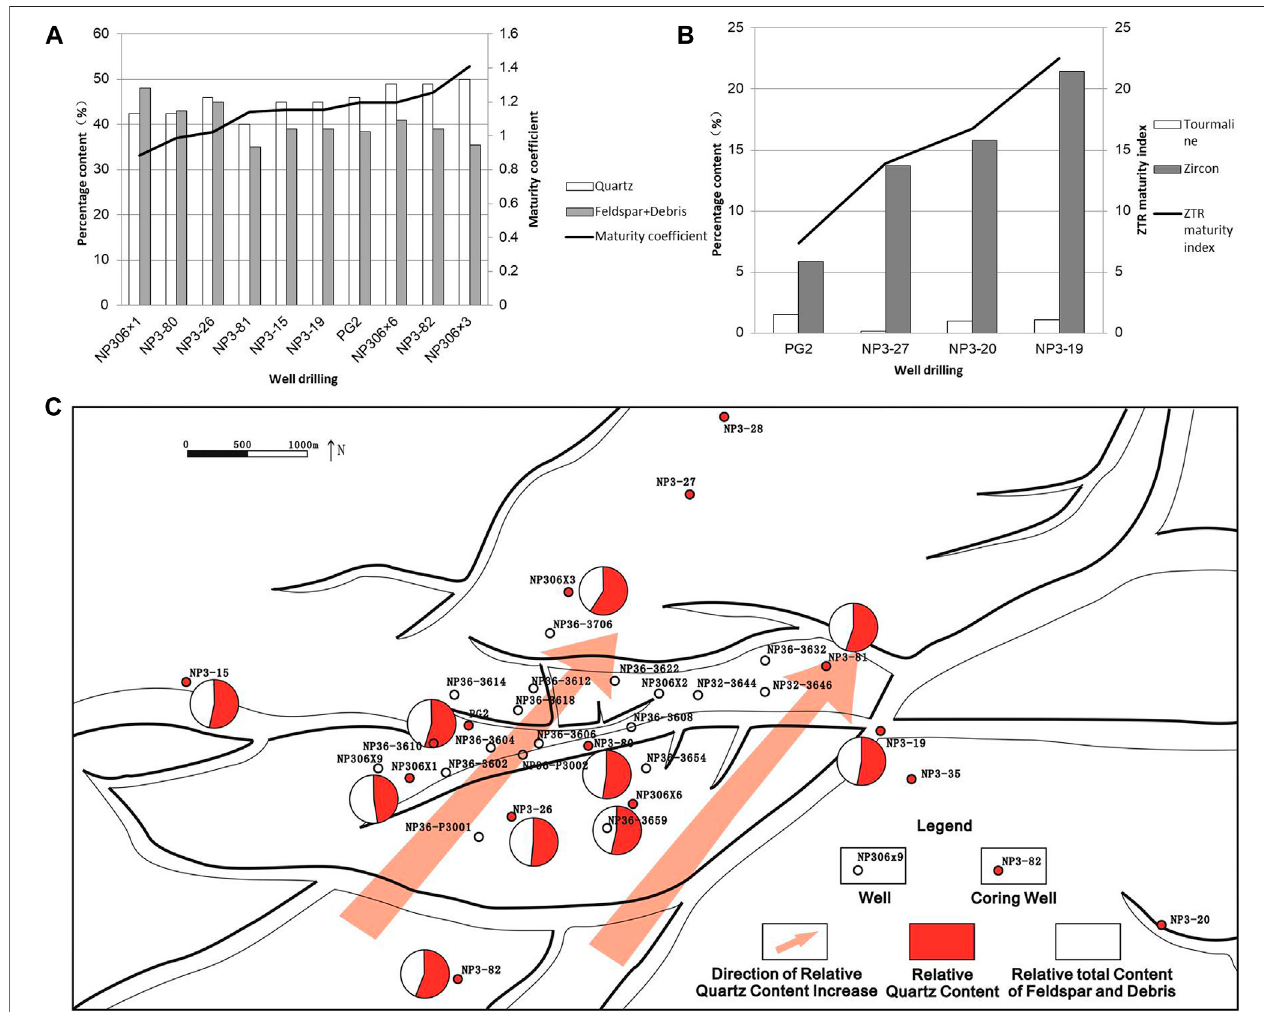
FIGURE 3 | Analysis results of material source directions in the middle and deep strata of the Nanpu No. 3 structural area. (A) Histogram of light mineral content of rock in different well areas; (B) Histogram of heavy mineral content of rock in different well areas; (C) Distribution trend of light mineral content in rocks of Nanpu No. 3 structural